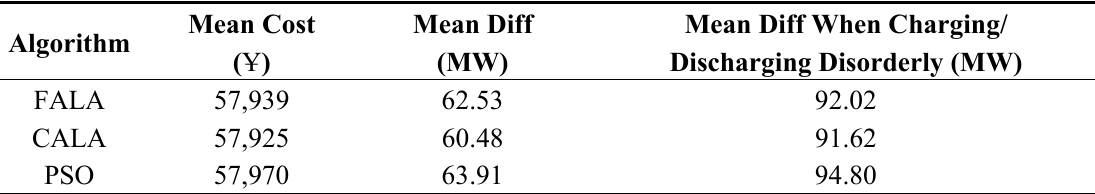
Table 3. Performance of algorithm results.